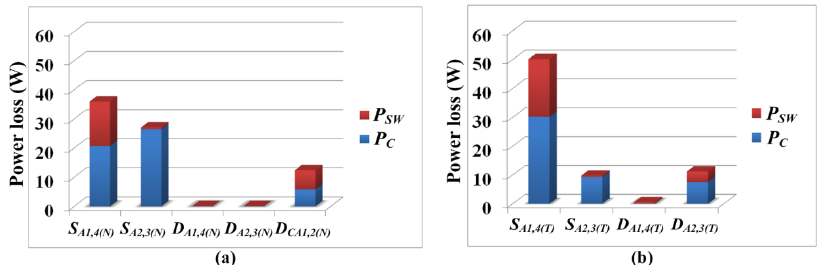
Figure 4. The power losses distributions: ( a ) NPC inverter; ( b ) T-type inverter at the rated power f sw of 20 with f sw of 20 kHz.